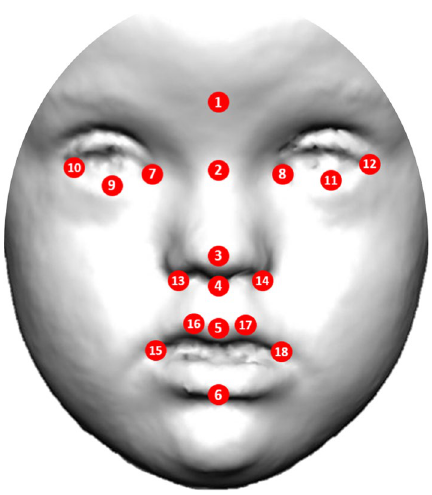
Figure 1. Anatomical position of facial landmarks used in morphometric and statistical analyses to quantify dysmorphologies associated to genetic and rare disorders Down, Morquio, Noonan syndromes and Neurofibromatosis type 1 in a Colombian